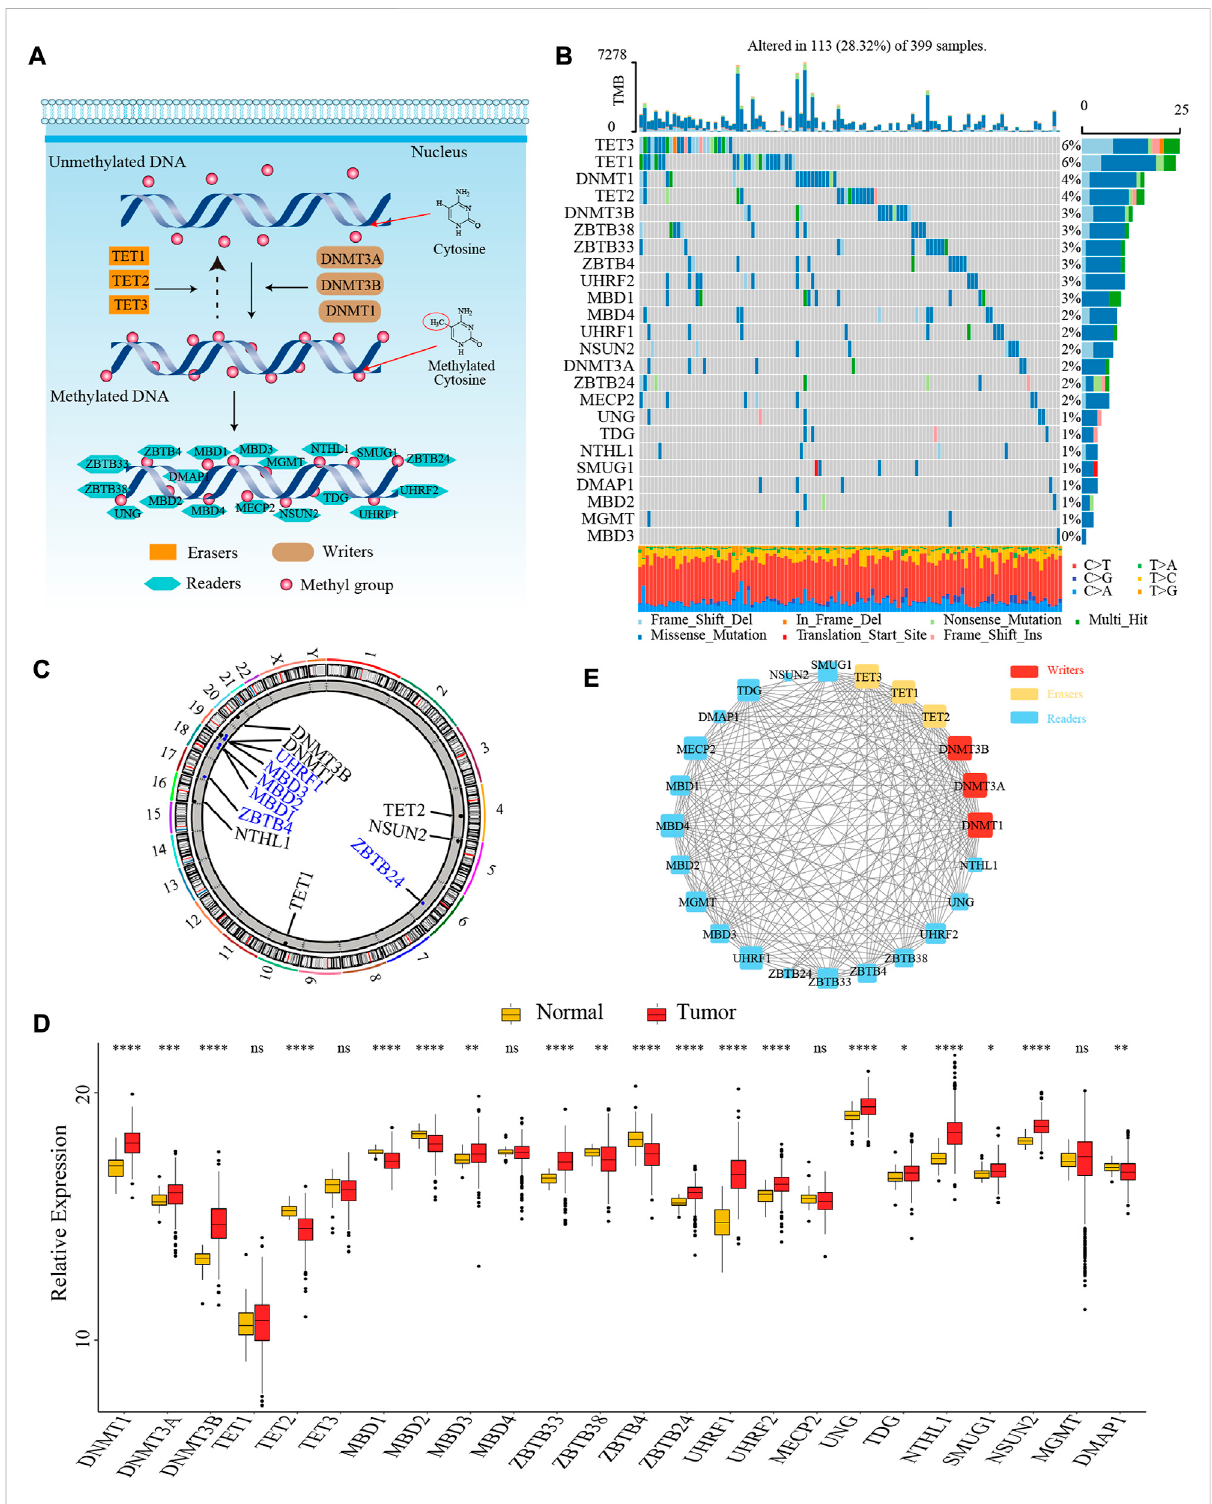
The landscape of genetic and transcriptomic variations of 24 DNA methylation regulators in colon cancer. (A) The dynamic reversible DNA methylationmodi fi cationprocessof24regulators. (B) Themutationfrequencyof24DNAmethylationregulatorsintheTCGA-COADcohort. (C) The locationofCNValterationofDNAmethylationregulatorson23chromosomesfromTCGA-COADcohort. (D) Theexpressionof24DNAmethylation regulators between colon cancer tissue and normal tissue (Wilcoxon test; ns: no signi fi cance; * p < 0.05; ** p < 0.01; *** p < 0.001; **** p < 0.0001). (E) The PPI network among 24 DNA methylation